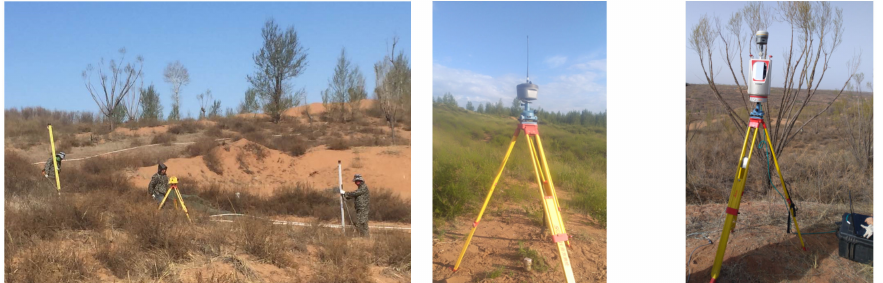
Figure 2. Images from the field